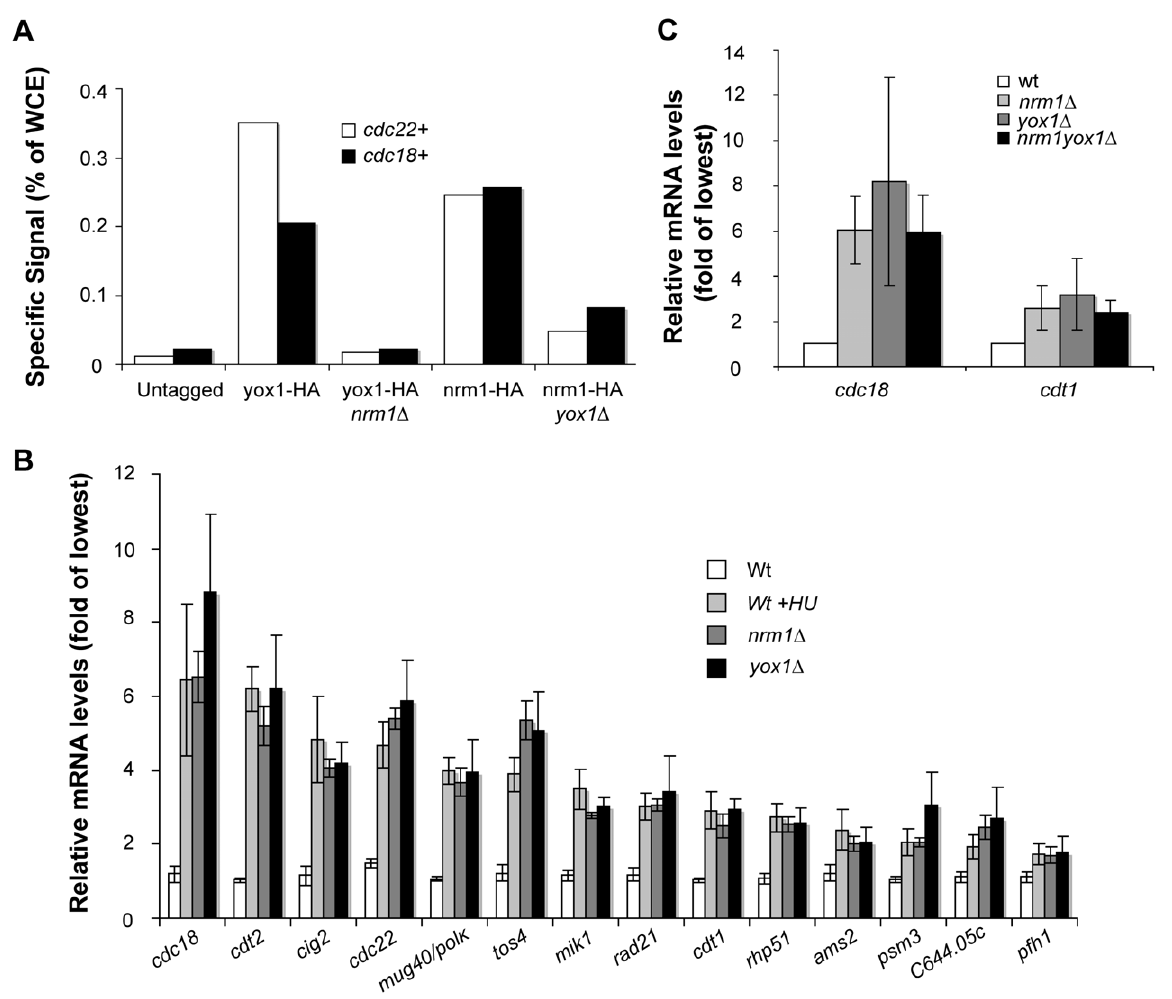
Figure 2. Yox1p and Nrm1 require each other to bind and repress MBF targets. (A) Chromatin-immune precipitated (ChIP) cdc22 and cdc18 promoter fragments pulled down by HA tagged Nrm1 and Yox1 in wild type, and yox1 D and nrm1 D cells, respectively, were quantified by qPCR. Enrichment is shown as percentage of WCE signal. Untagged cells were included as negative control and data shown are representative of multiple independent experiments (see Figure S1 for a biological repeat experiment). (B) Relative mRNA levels obtained by RT-qPCR for 14 MBF-dependent transcripts in untreated and HU treated wild type cells and nrm1 D and yox1 D cells. Transcript levels are shown as fold induction of transcript levels detected in wild type untreated cells. Bars represent the average value, and error bars represent their SD, obtained by qPCR of triplicate biological samples. (C) RT-PCR analysis of the relative levels of cdc18 + and cdt1 + transcripts in wild type, nrm1 D , yox1 D and nrm1 D yox1 D cells in untreated conditions and as percentage of maximal levels (100%). Bars represent the average value, and error bars represent their SD, obtained by qPCR of triplicate biological samples.